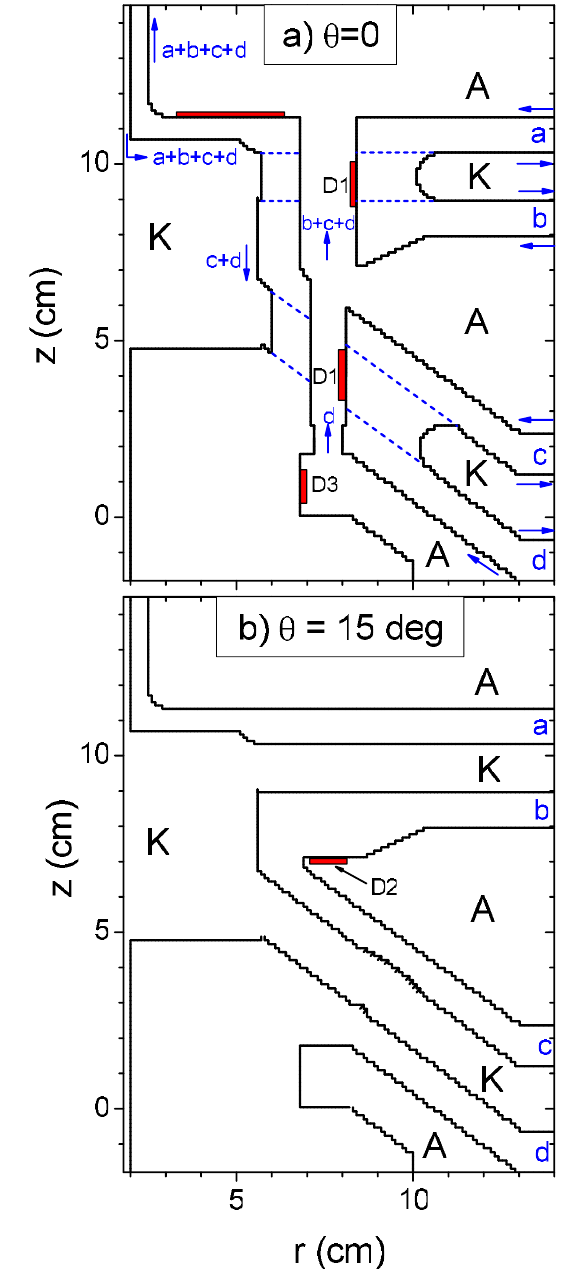
FIG. 2. (Color) Views of the simulation geometry for the 2-cm load simulations in the (cid:1) (cid:4) 0 and 15-degree planes. Anode and cathode components are labeled ‘‘A’’ and ‘‘K,’’ respectively, and the lower case letters (a–d) indicate the four input levels for the circuit drivers. The dashed blue lines in (a) indicate the connec- tion of the cathode components outside of the (cid:1) (cid:4) 0 plane. The current paths and summation are labeled with blue arrows and letters (after Fig. 2 of Pointon et al. [4]). The load model is attached at the outlet boundary at the top of each